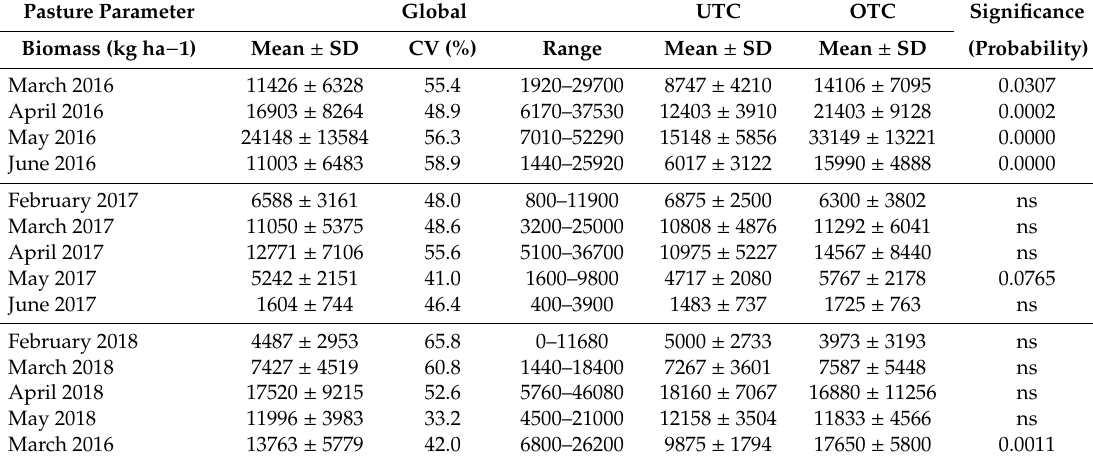
Table 2. Pasture productivity (biomass, kg ha − 1 ) of the studied field for each sampling date: Global (all sampling points), UTC (12 sampling points under tree canopy), and OTC (12 sampling points outside tree canopy).